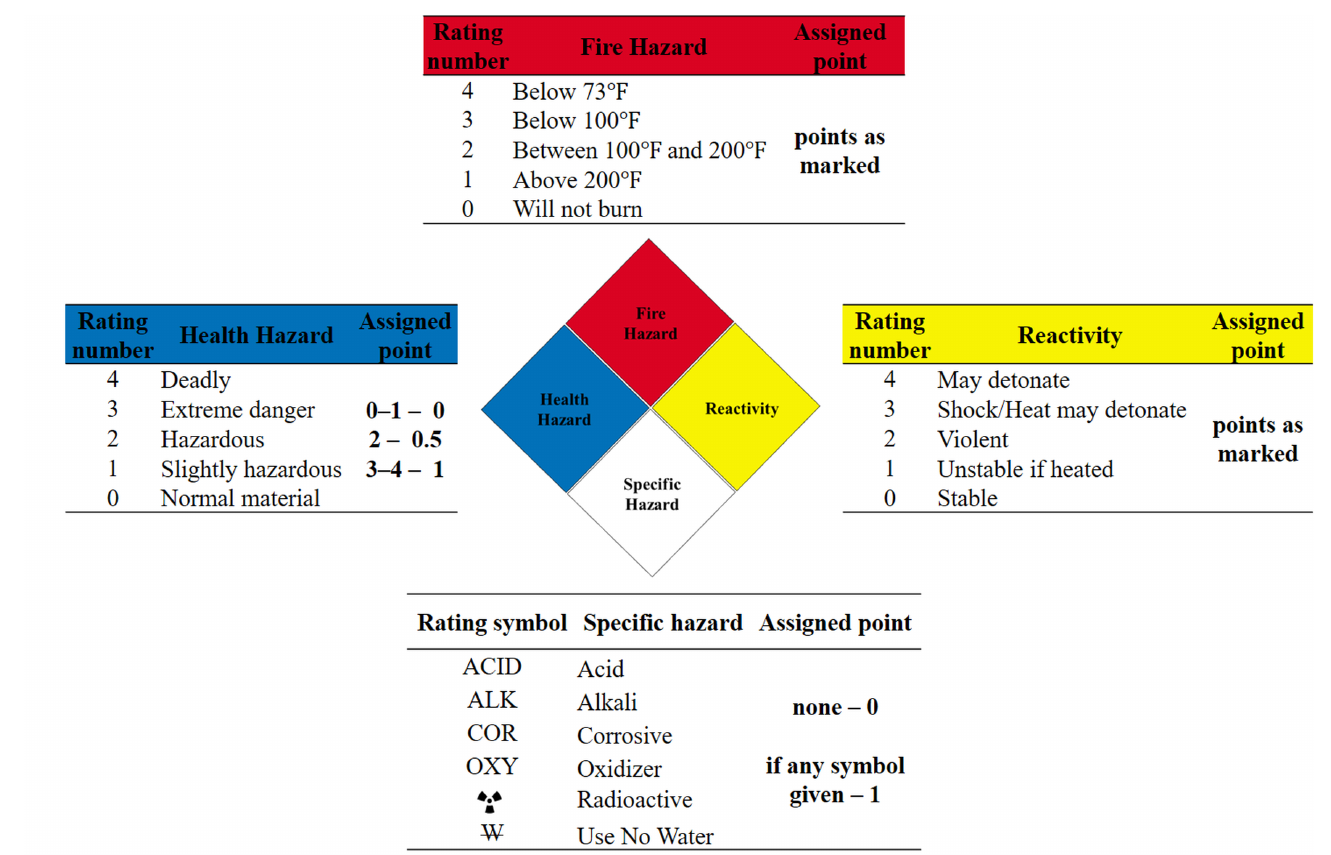
Figure 2. Points assessment guideline with use of Hazard NFPA 704